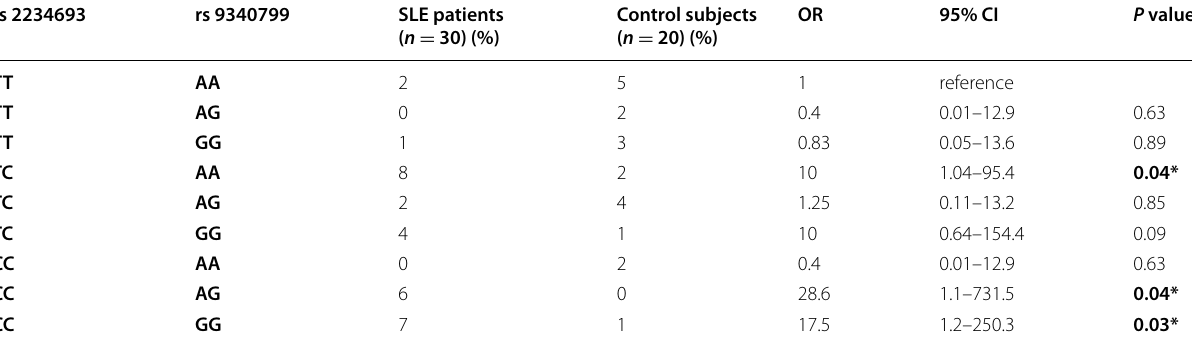
Table 4 Comparison among SLE patients and controls regarding the frequency of Combinations of the rs1(2234693) and rs2 (9340799)